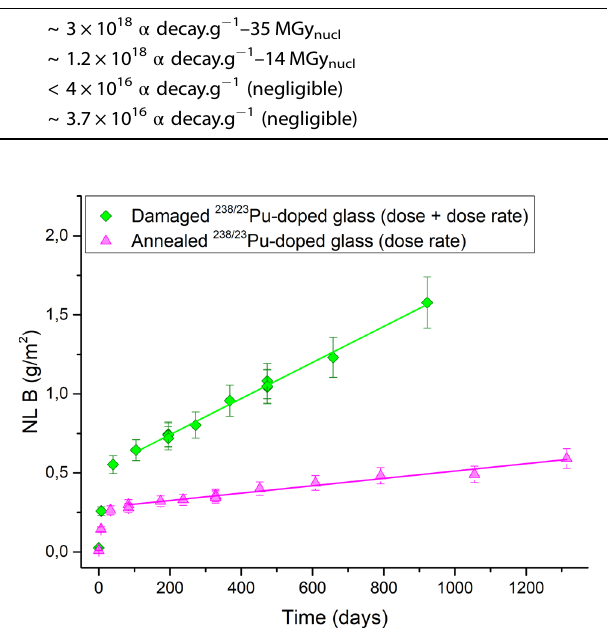
Fig. 2 Boron releases versus time for doped glasses leaching test and references experiments. Boron normalized mass loss (NL B) versus time for the 238/239 Pu- and 239 Pu-doped glass leaching tests (pink triangles and inversed purple triangles, respectively) and reference experiments ( ‘ ref. 1 ’ with open circles and ‘ ref. 2 ’ with open stars). The residual alteration rate value (Rr) associated with each experiment is given. Error bars are of ±10% and their calculation is detailed in the “ Solution analyses ” section.